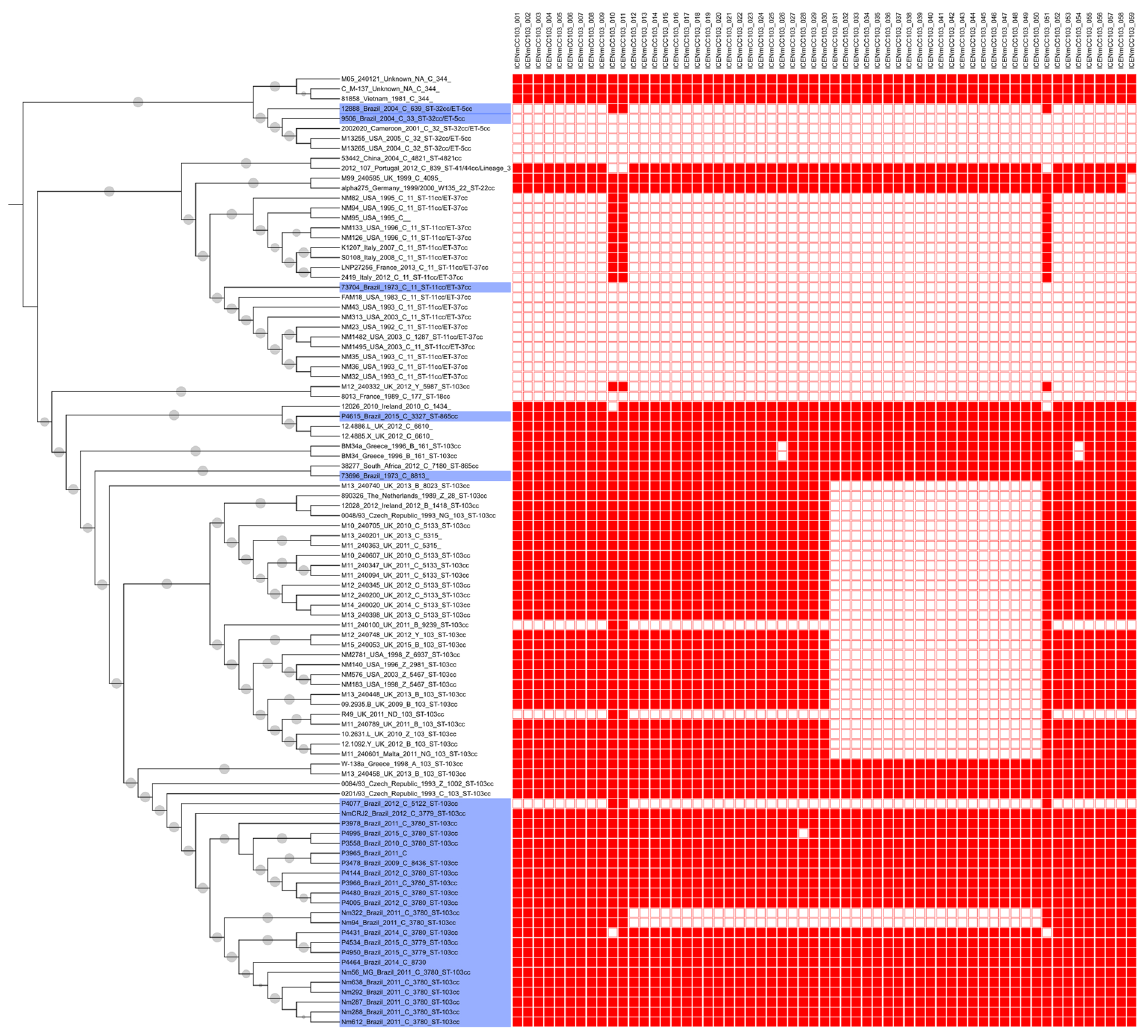
Figure 5. Phylogeny of N. meningitidis from CC103 and close relatives associated with a heatmap of the ICE Nm CC103 gene content. The genes listed in the top correspond to ICE Nm CC103 genes. The gene content is represented as presence (red) or absence (white). Most of CC103 genomes, including genomes from Brazil, belong to a monophyletic cluster and carried the ICE Nm CC103 element. All genomes from Brazil are shaded in